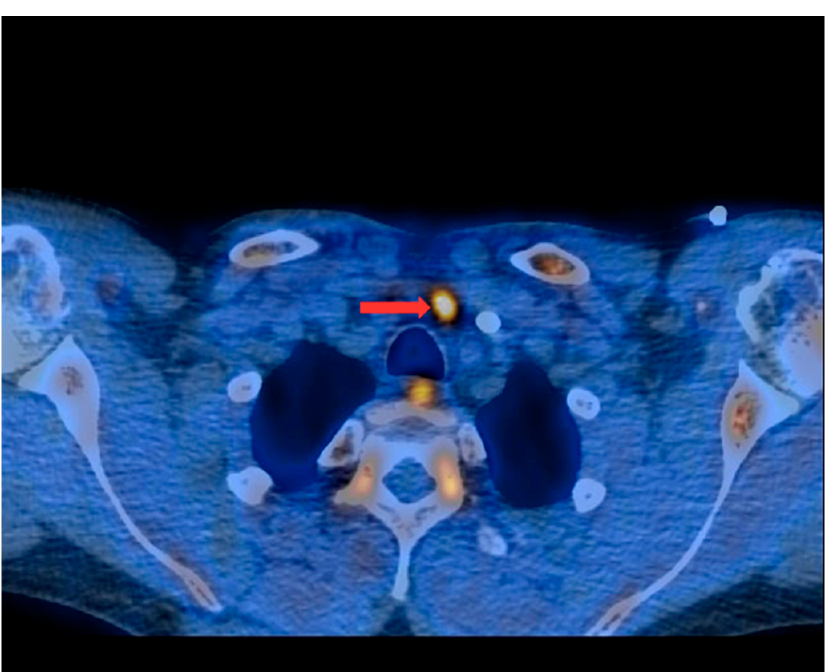
Figure 2. PET/CT with [ 11 C]MET—axial projection. Visible focus of increased radiotracer accumulation (red arrow) corresponding to the parathyroid gland in front of the trachea, at the left-hand side of the midline of the body.